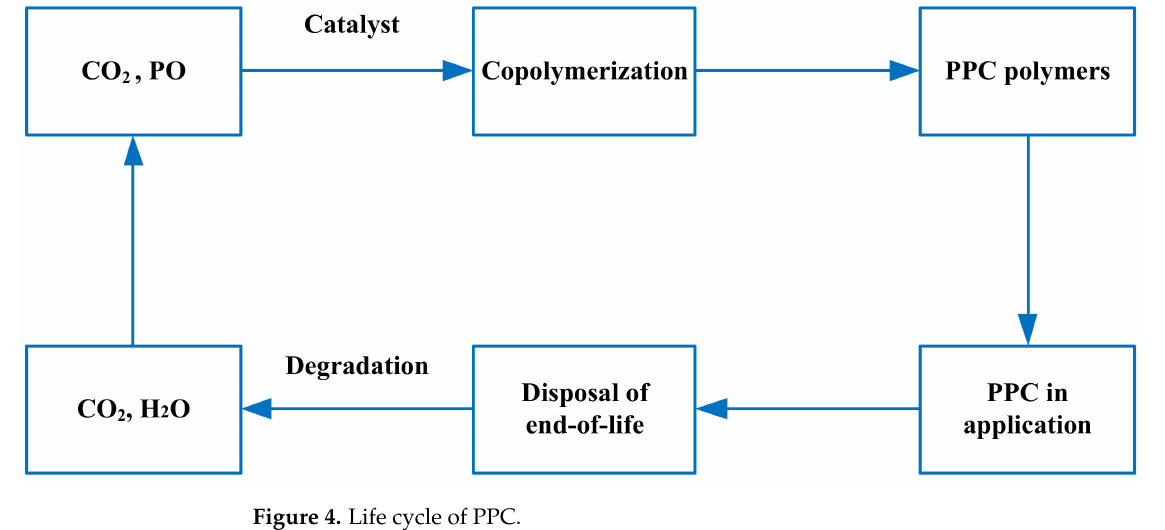
Figure 4. Life cycle of